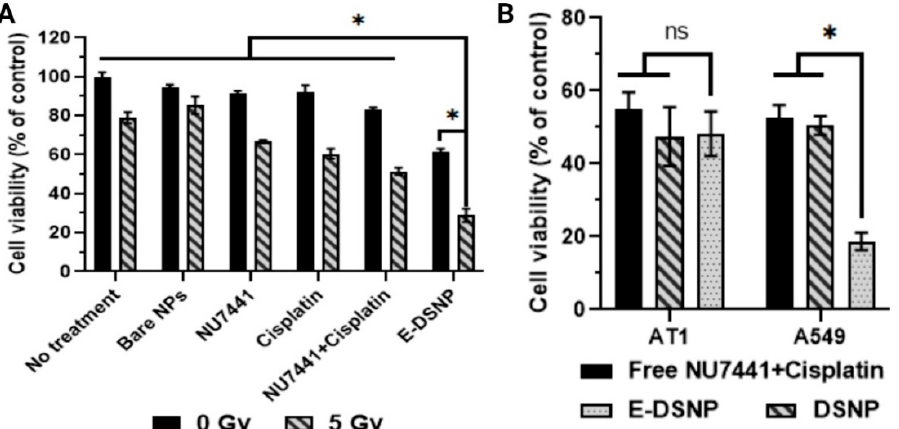
Figure 7. Investigation of in vitro cancer cell killing ability of dual drug loaded E-DSNPs. ( A ) In vitro therapeutic efficacy of dual drug loaded E-DSNPs with 5 Gy radiation treatment observed significantly lower cell viability of A549 lung cancer cells compared to cells treated with E-DSNPs without radiation treatment and single drug loaded NPs or free drug controls (±RT). ( B ) E-DSNPs exert higher toxicity to A549 cells due to targeting via EphA2 receptors but produce similar cancer cell death as untagged controls in AT1 cells due to poor targeting efficiency. (* Statistically significant with p < 0.05).